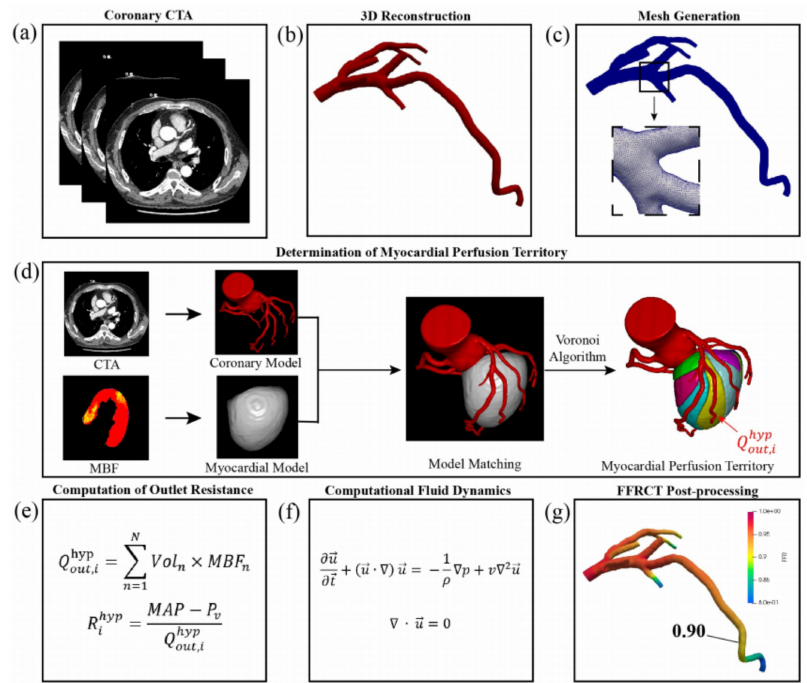
Figure 2. The process of FFR non-invasive calculation based on CTP. ( a ) Acquisition of coronary CTA; ( b ) 3D reconstruction of coronary artery; ( c ) meshing of 3D models of coronary artery; ( d ) deter- mination of myocardial perfusion territory; ( e ) computation of outlet resistance; ( f ) Navier–Stokes equations that govern the fluid dynamics of blood; ( g ) post-processing of patient-specific FFR-CT. Adapted from Xue et al.